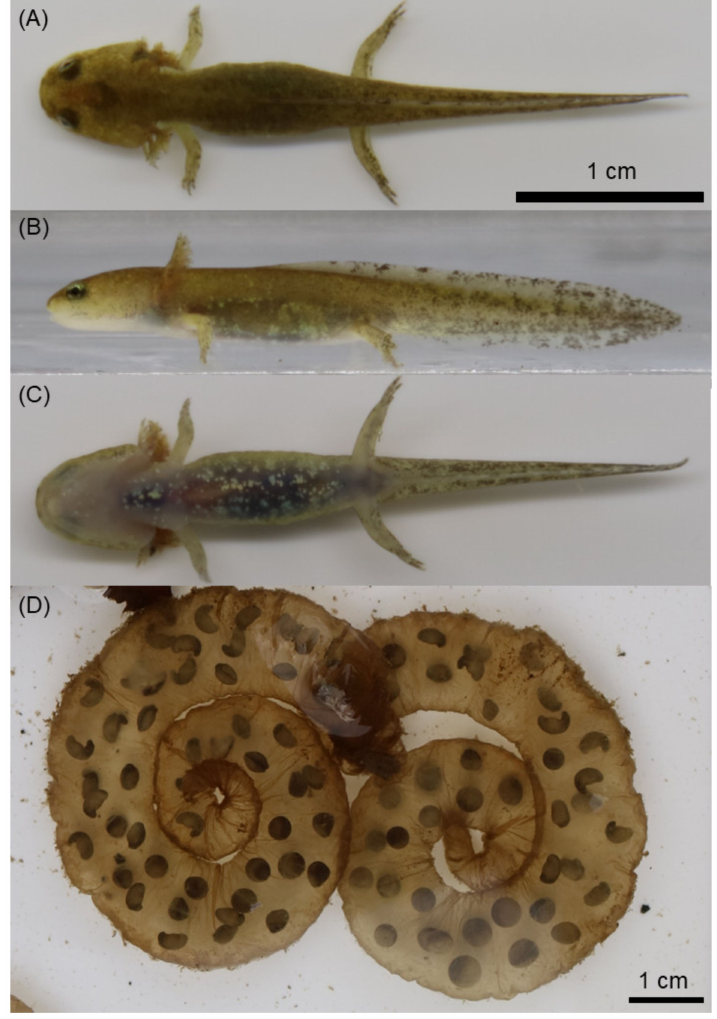
Figure 6. Larva of Hynobius kunibiki sp. nov.: ( A ) dorsal, ( B ) lateral, and ( C ) ventral sides, as well as ( D ) egg